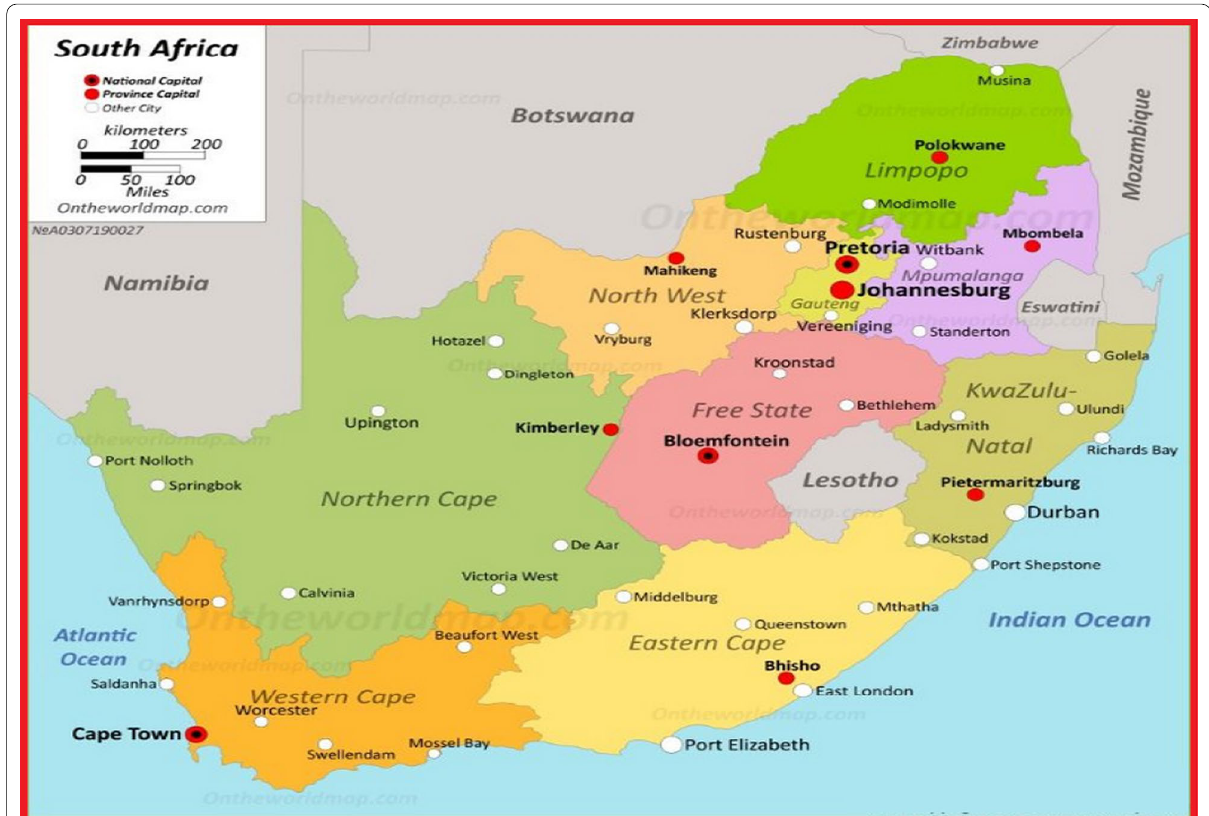
Fig. 5 Map of South Africa showing the provinces (Ontheworldmap